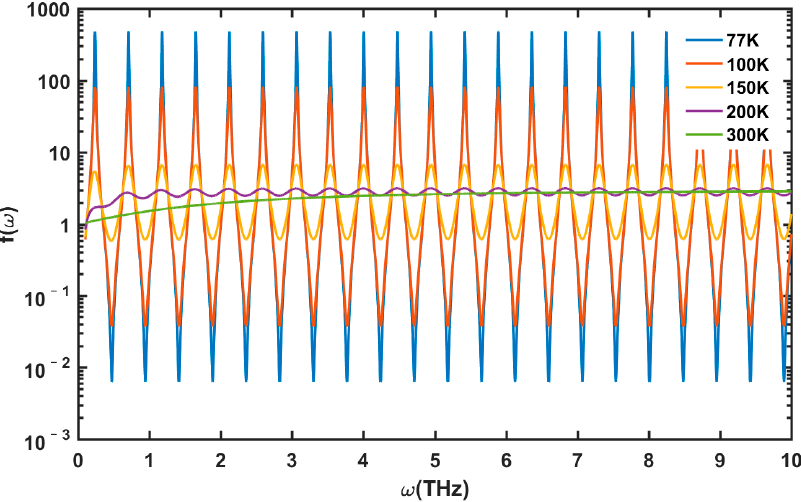
Figure 4. Variations in f( ω ) with temperature in frequency range of 0.1–10 THz. Other parameters are taken as n s = 1 × 10 13 /cm 2 N dis = 10 10 /cm 2 , Δ = 1 nm, and Λ = 10 nm.